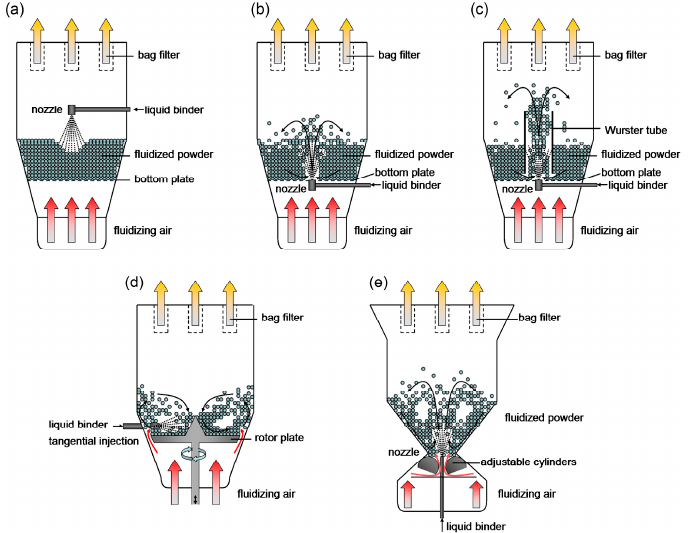
Figure 1. Representative configurations of wet fluidized bed granulators and coaters: ( a ) Top spray granulator, ( b ) bottom spray granulator, ( c ) Wurster granulator, ( d ) rotor granulator, and ( e ) spouted bed granulator. Reproduced from reference [53] permitted by